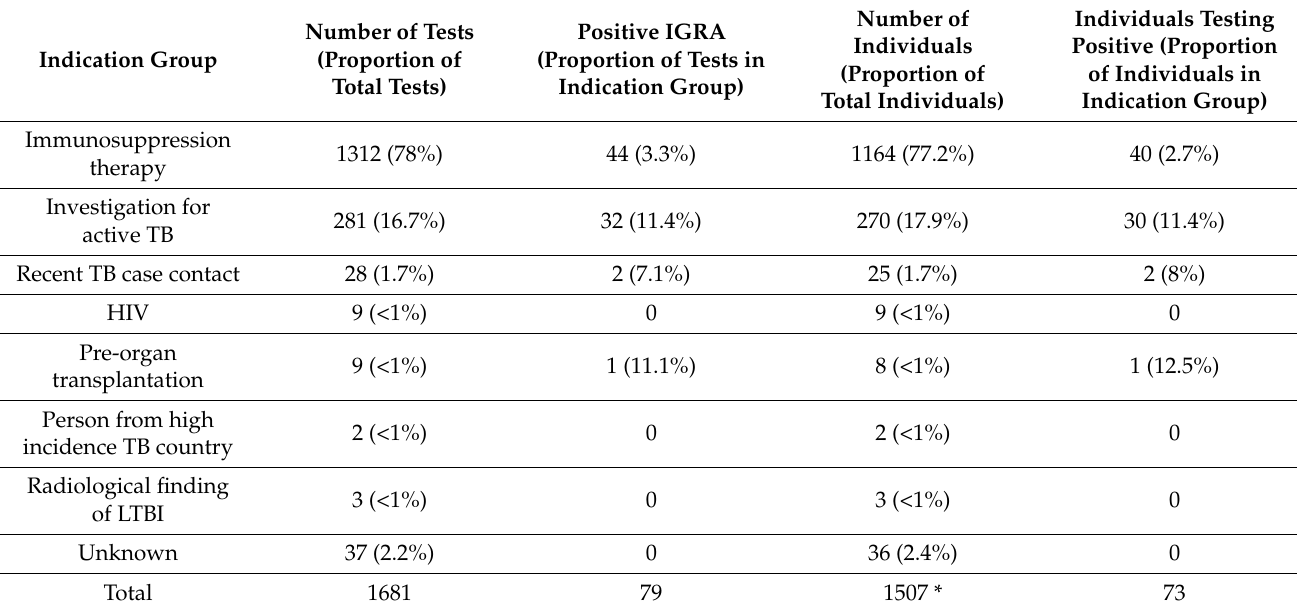
Table 1. Indications for screening and outcomes of IGRA